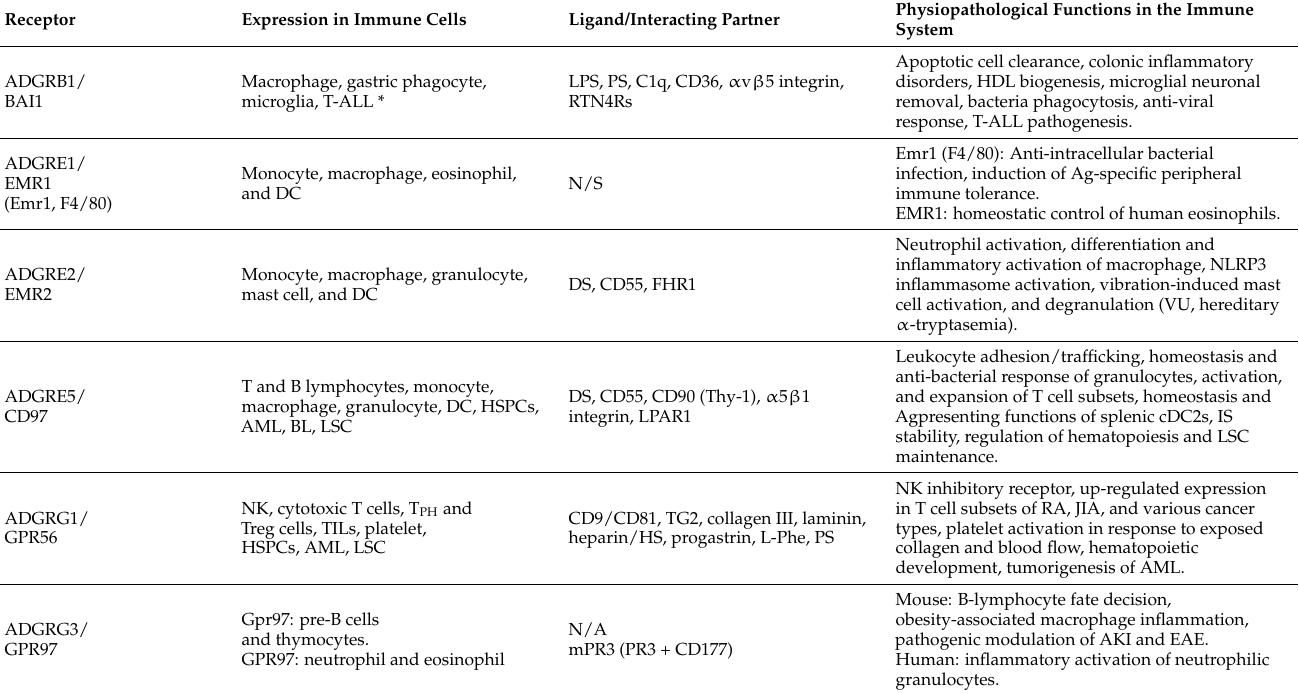
Table 1. Molecular characteristics and physiopathological roles of immune